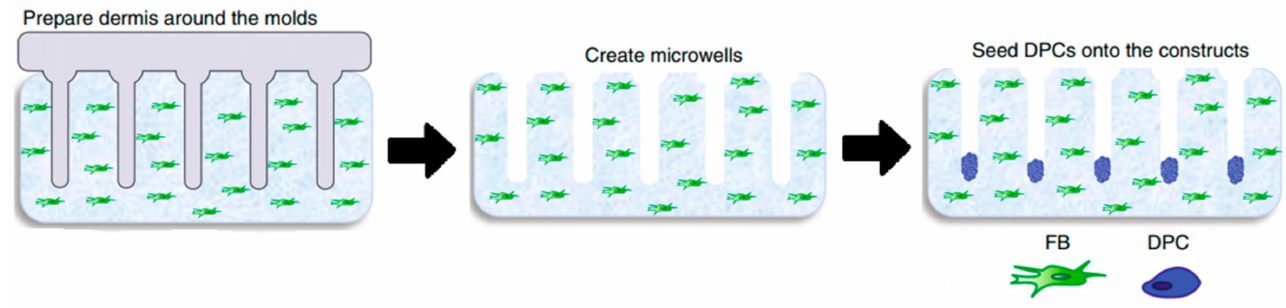
Figure 4. Molds were used to create an array of microwells from the collagen gel containing dermal fibroblasts, in which DPCs were allowed to form spontaneous aggregates. DPCs—dermal papilla cells; FB—fibroblasts. Reproduced with permission from